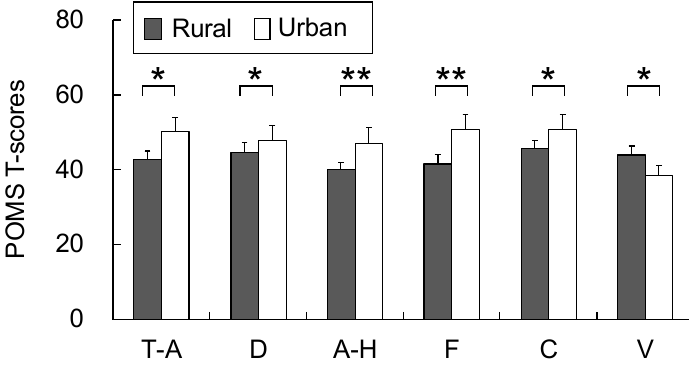
Figure 7. Comparison of the Profile of Mood States (POMS) scores after exposure to the rural and urban landscapes. Mean ± SE; N = 11; * p < 0.05; ** p < 0.01; Wilcoxon signed- rank test. T–A, tension–anxiety; D, depression; A–H, anger–hostility; F, fatigue; C,